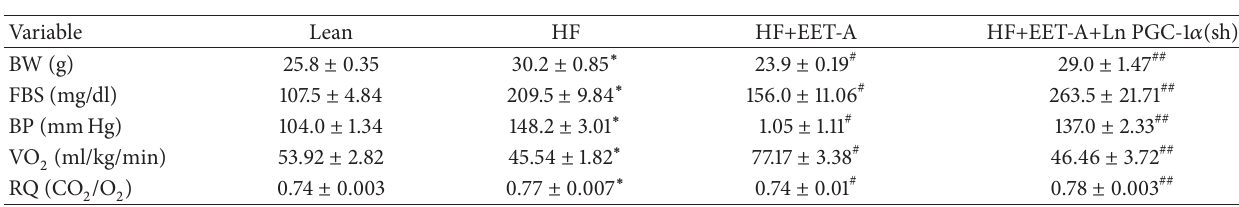
Table 1: (a) EET-agonist treatment (4 weeks) WT and Ln PGC-1 𝛼 (sh) mice. Body weights, fasting blood glucose, blood pressure, oxygen consumption, and respiratory quotient of mice fed regular chow or HF diet for 8 weeks. EET-A administered for the last 4 weeks. (b) EET- agonist treatment (8 weeks) WT mice. Body weights, blood glucose, oxygen consumption, and respiratory quotient of mice fed regular chow or HF diet for 24 weeks. EET-A administered for the last 8